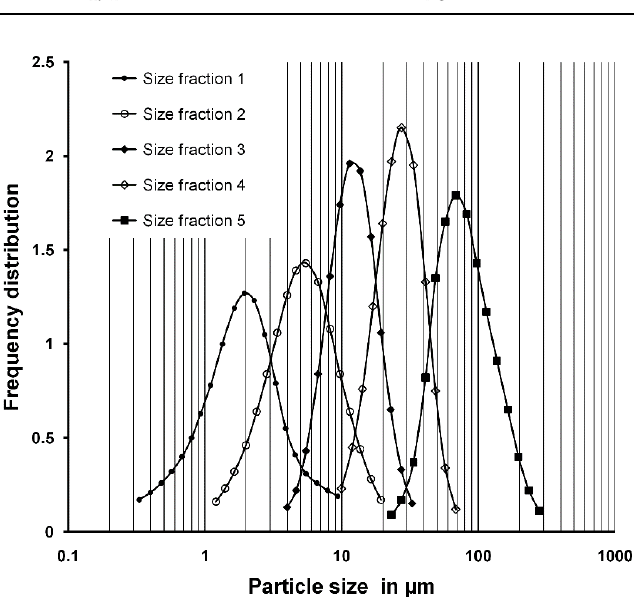
Figure 1. Particle size distribution of the size fractions produced from the ash by air classification.